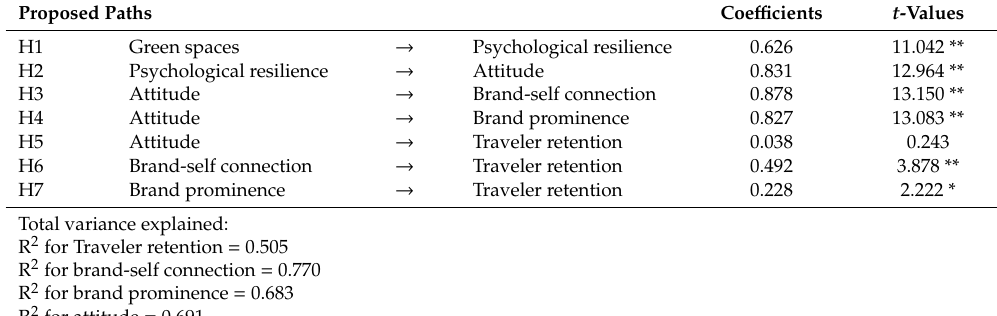
Figure 2. Results of the structural model and baseline model assessment (n = 403). Goodness-of-fit statistics for the structural model: χ 2 = 381.640, df = 238, p < 0.001, χ 2 / df = 3.469, RMSEA = 0.078, CFI = 0.943, IFI = 0.943, TLI = 0.930. Goodness-of-fit statistics for the baseline model: χ 2 = 593.956, df = 231, p < 0.001, χ 2 / df = 2.571, RMSEA = 0.063, CFI = 0.923, IFI = 0.924, TLI = 0.909, ** p < 0.01. Table 3. Structural model estimation (n = 403).